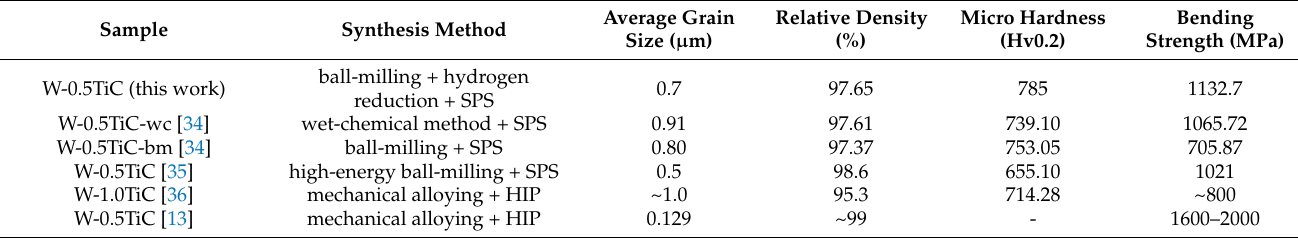
Table 1. Physical and mechanical properties of the sintered W-TiC alloys prepared by different synthesis methods.